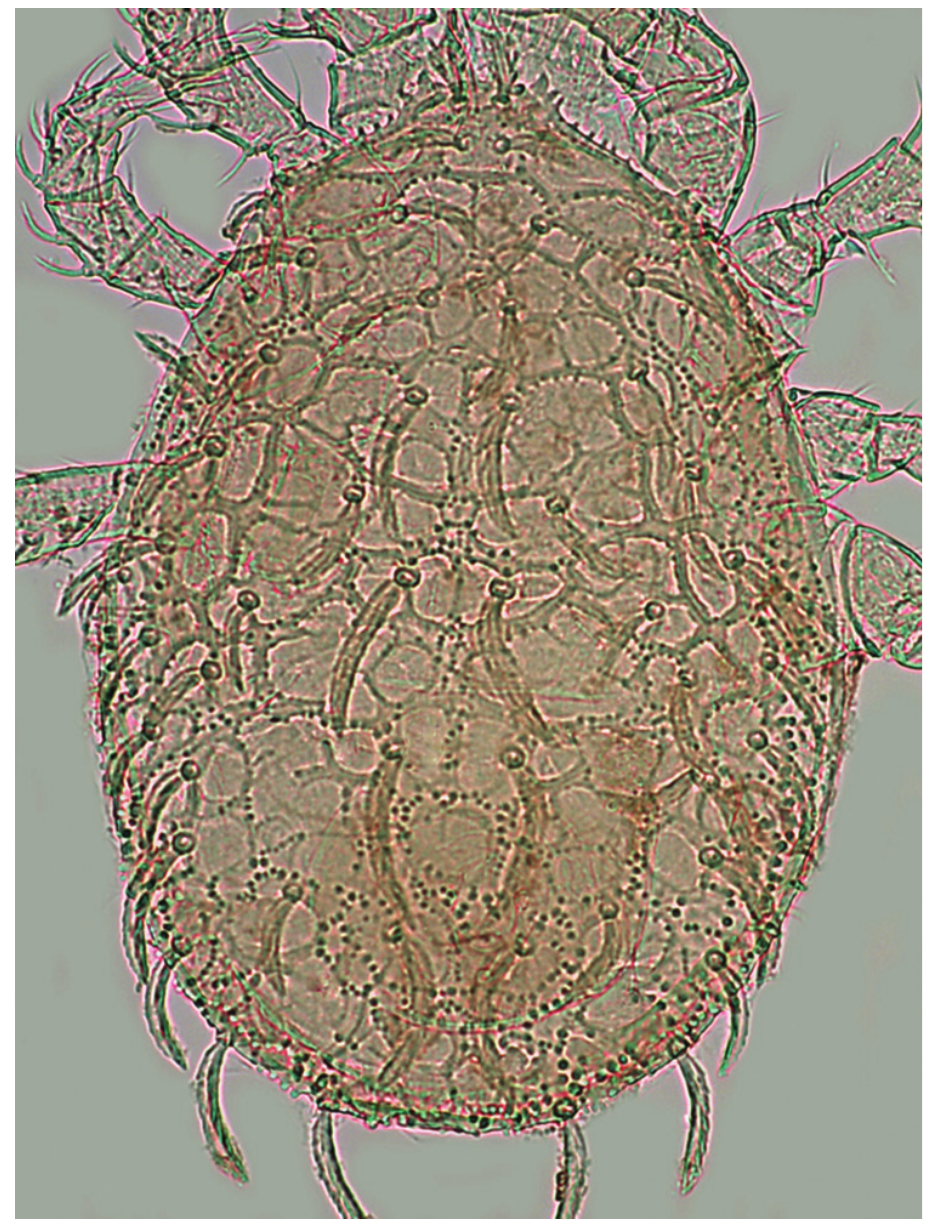
Plate 19. Ameroseius lehtineni , female (holotype, from Finland), dorsal